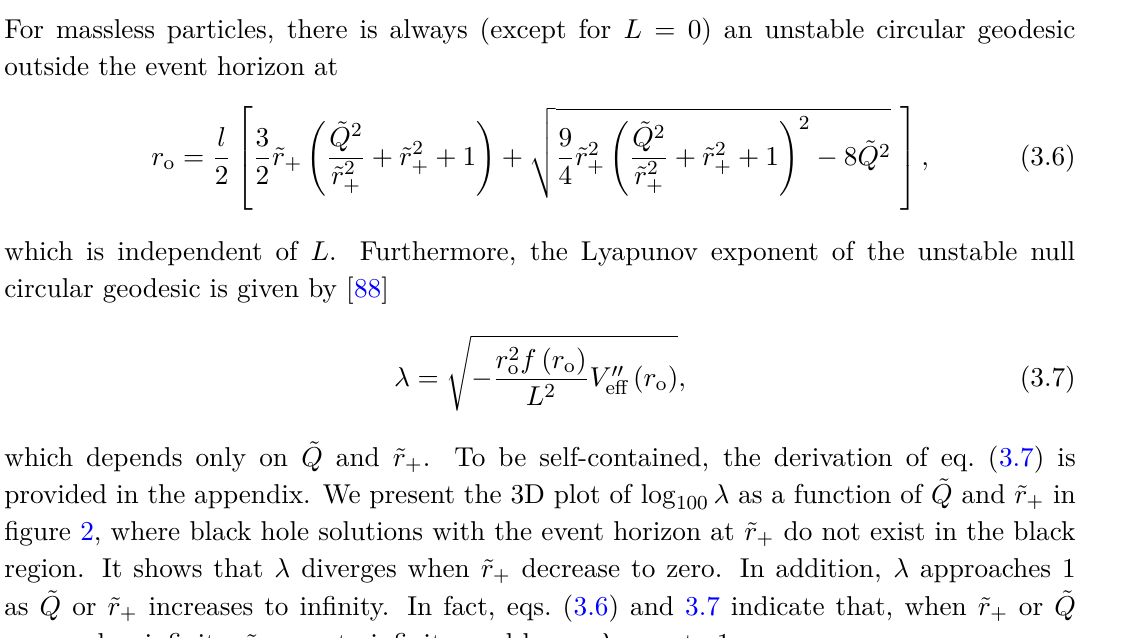
Figure 2 . Three-dimensional plot of log geodesics. Black hole solutions do not exist in the black